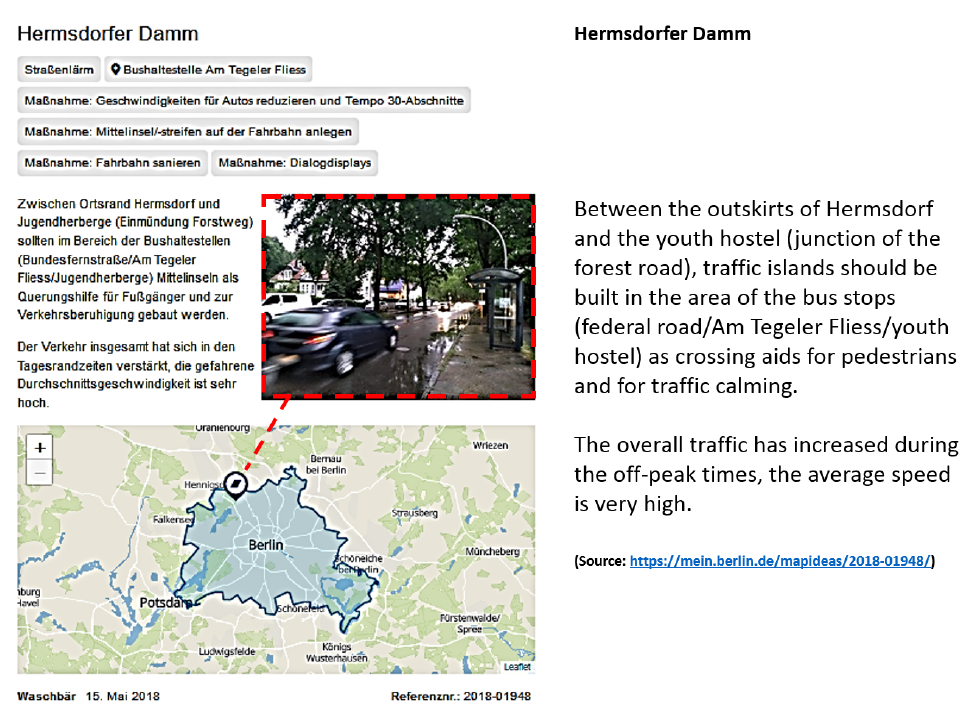
Figure 4. Traffic Island (authors’ own translation). Edited by the authors based on images from the ‘meinBerlin’